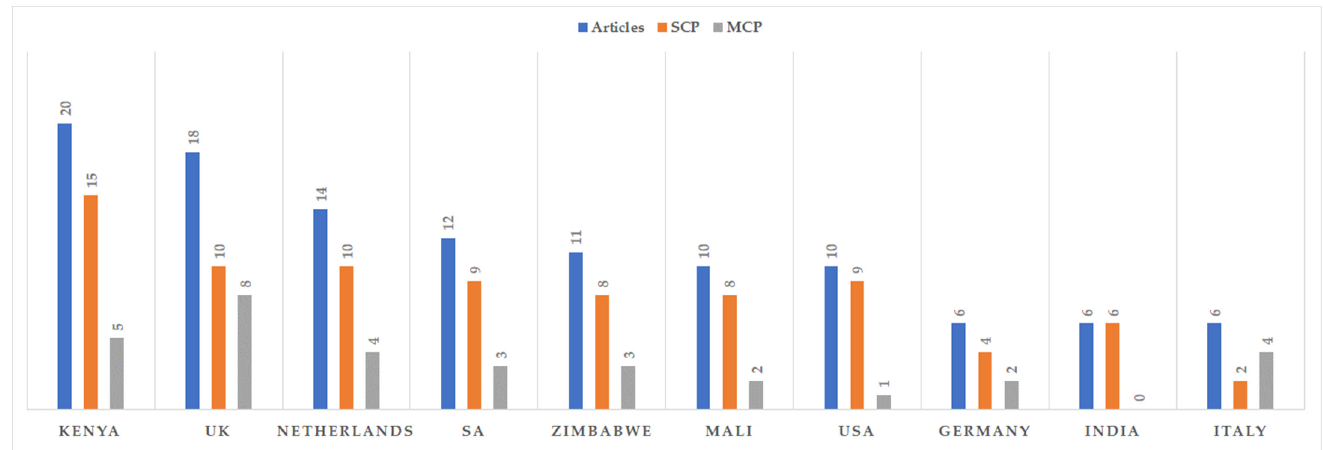
Figure 3. Top ten leading countries in climate-smart agriculture research publications. The ranking is based on the corre- sponding author’s country. SCP: single-country publications; MCP: multiple-country publications.